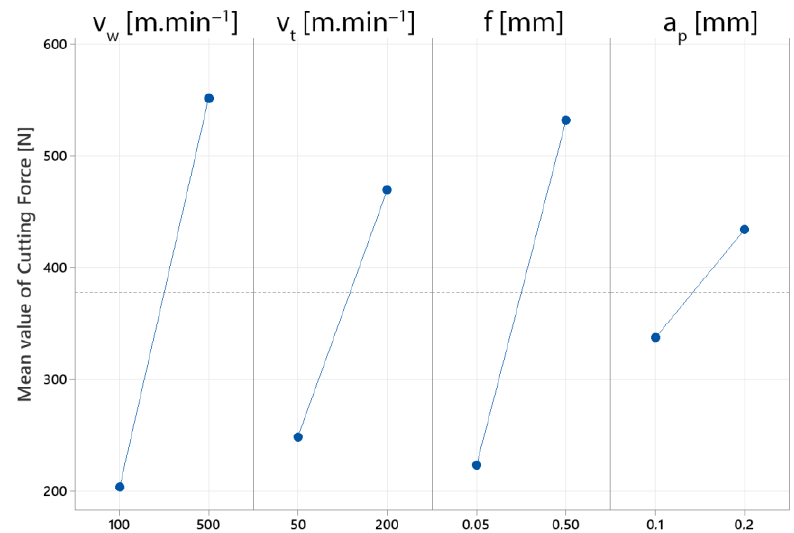
Figure 7. Main effects plot for maximal cutting force.